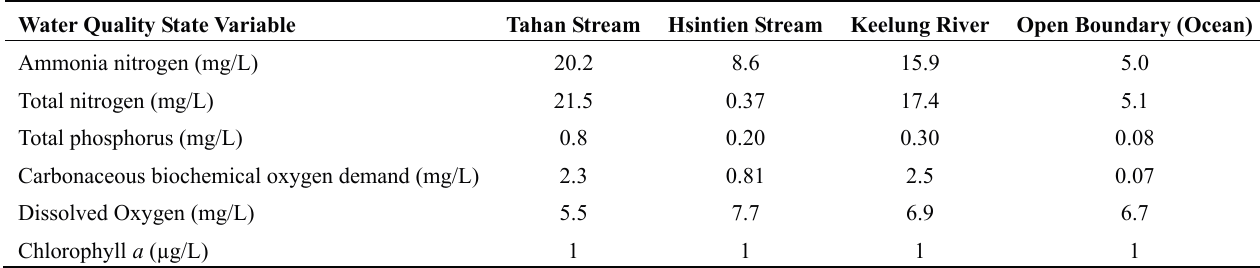
Table 7. The water quality specified at the upstream and ocean boundaries for model simulation.